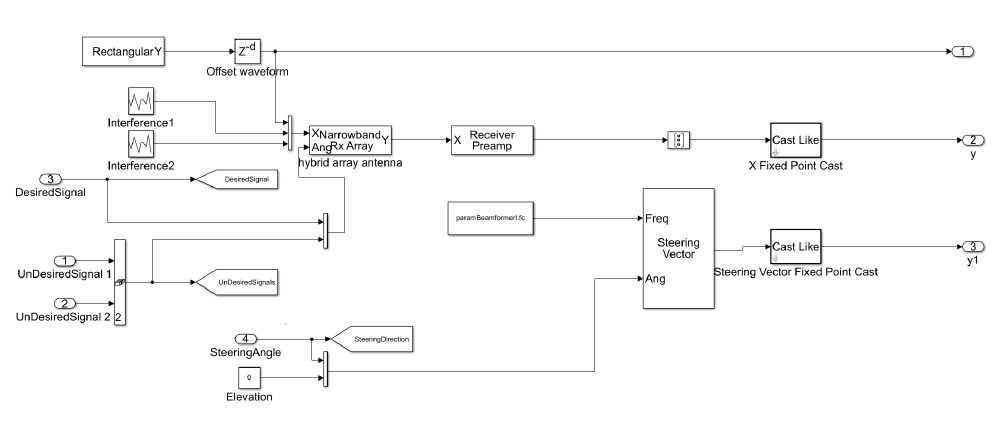
Figure 6. The aforementioned subsystem in Figure 4, the LCMV beamforming technique, and other mathematical operations in the real environment. The Simulink demonstration of all mathematical operations in the MATLAB platform with detail.